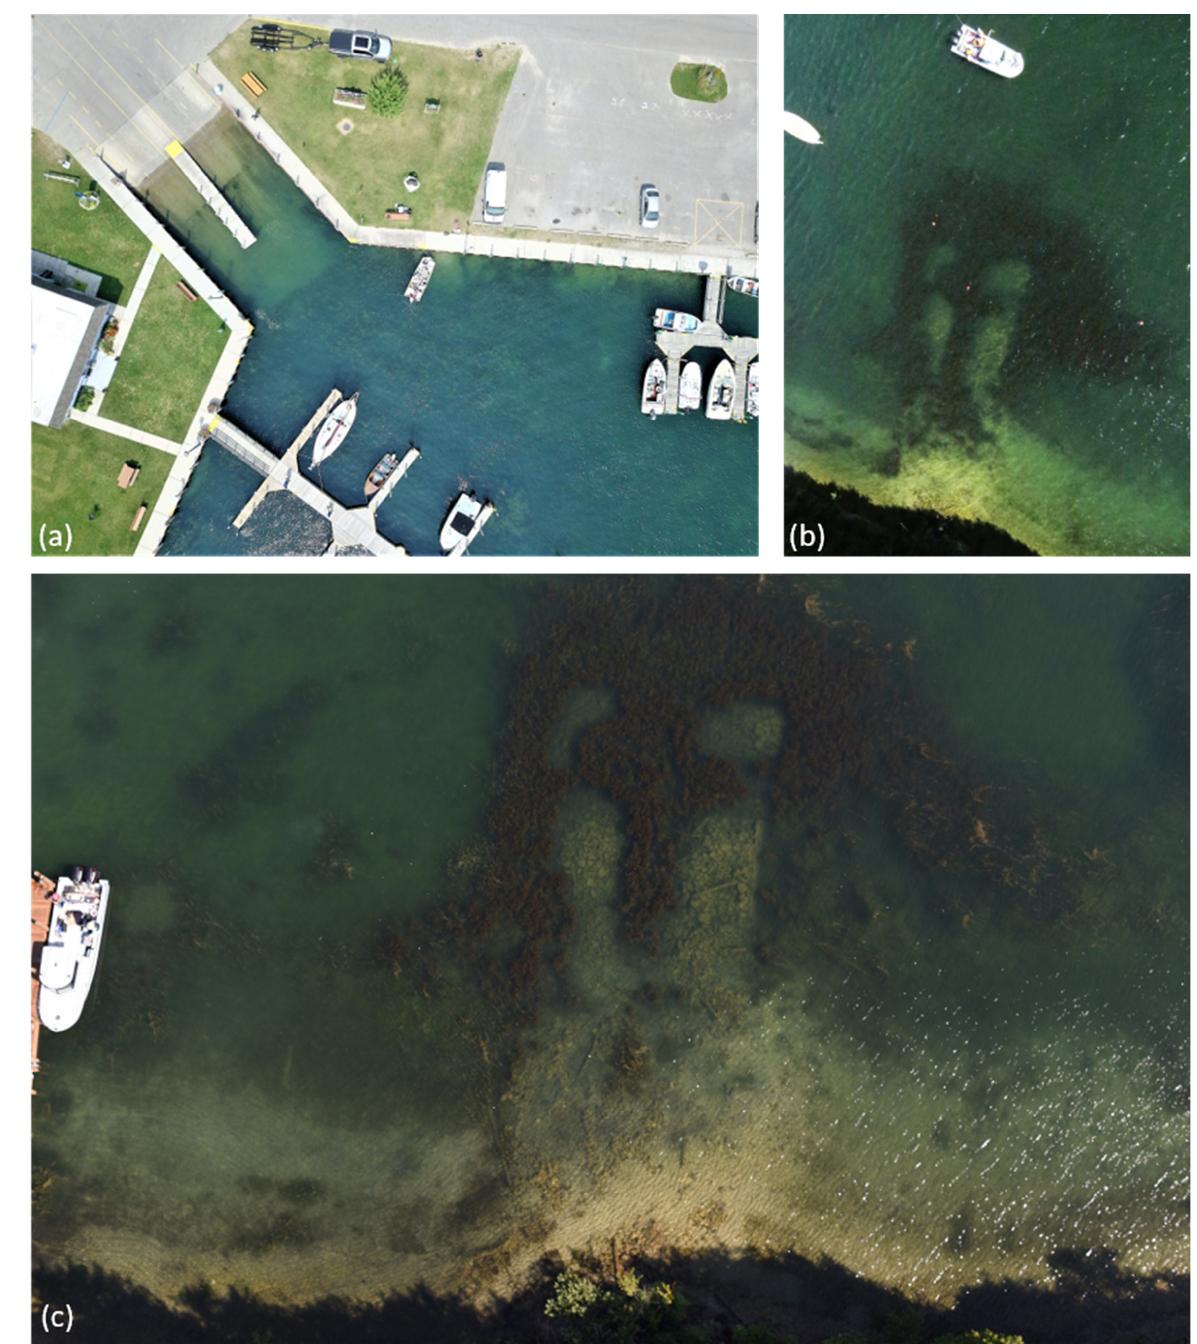
Figure 2. Examples of RGB UAS imagery: ( a ) Hessel Marina from a 12mp Mavic Pro camera, ( b ) Howells Dock from a 16mp Canon camera (this provided the natural color part of the VISNIR system), and ( c ) Howells Dock from a 36mp Nikon D810 camera.